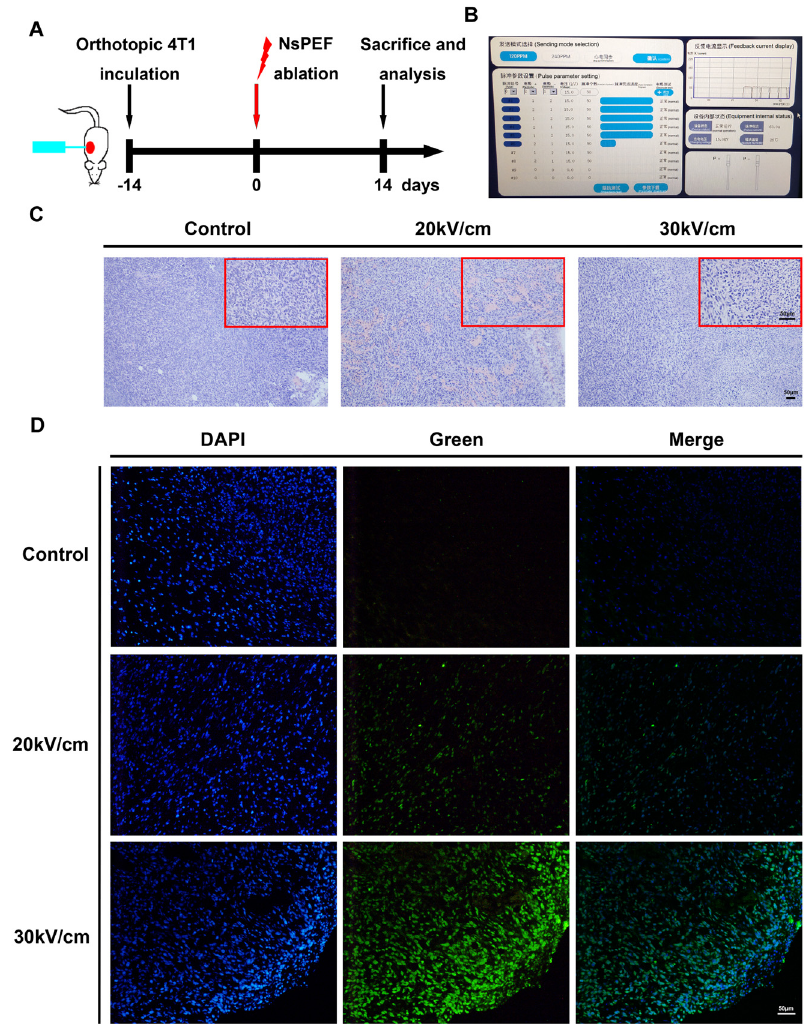
Figure 1. NsPEF induces apoptosis of solid tumors. ( A ) Flow chart of animal ablation. ( B ) Working interface of the nanosecond pulsed tumor ablation system. ( C ) HE staining of tumors in the control group, 20 kV/cm group, and 30 kV/cm group at 0 h after nsPEF treatment. The larger HE images were captured under a 10 × objective, while the smaller images were captured under a 40 × objective. Scale bars: 50 µ m. ( D ) TUNEL essay at 0 h by nsPEF (magnification: 20 × objective; scale bar: 50 µ